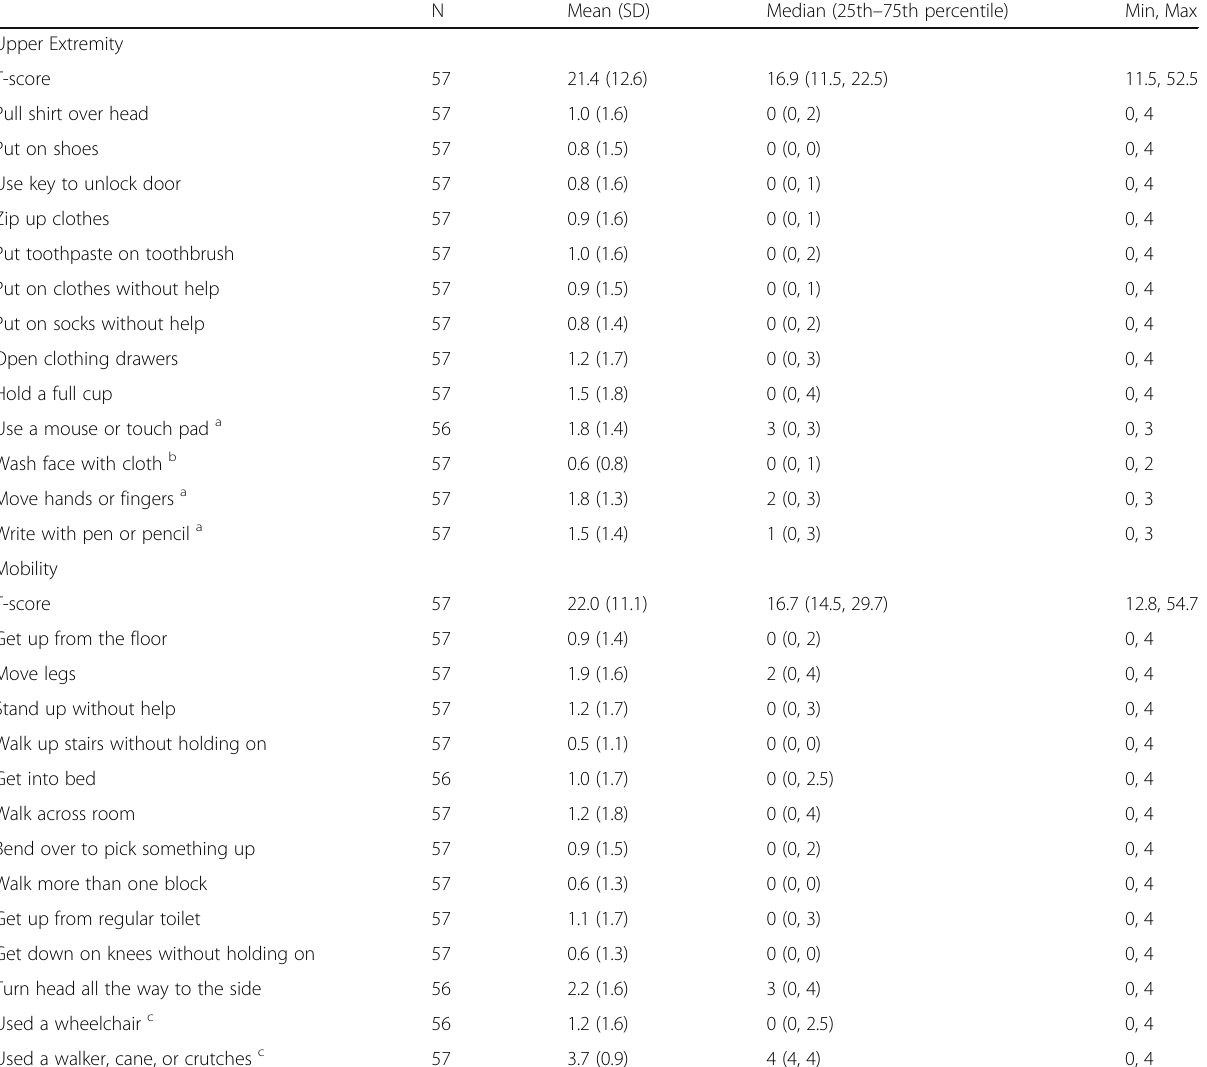
Table 3 Raw item scores and Upper Extremity and Mobility